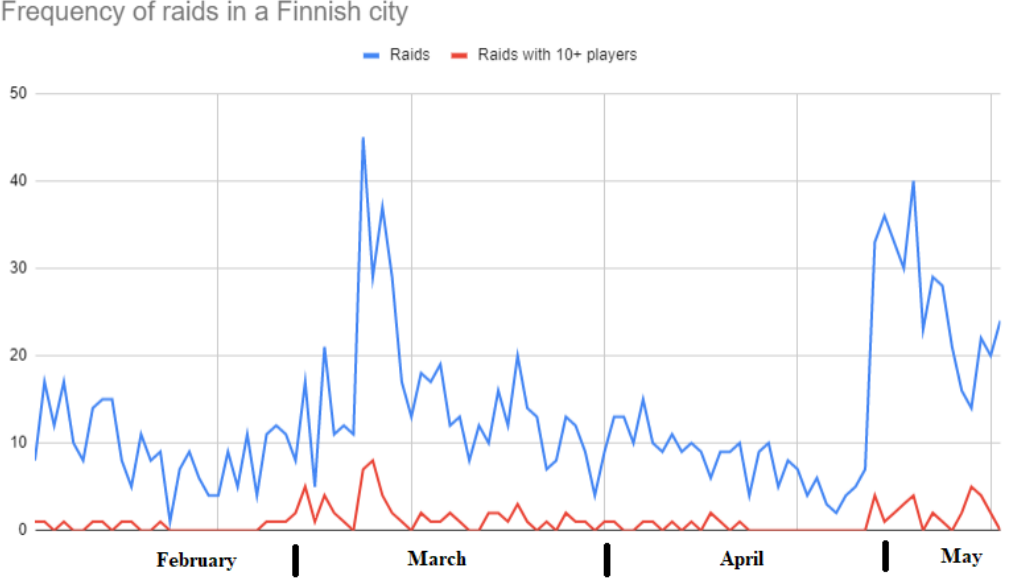
Figure 4. Displaying the changes in daily number of legendary raids organized in the largest public raid chat in a Finnish city during 1 February–12 May 2020. Each column in the figure corresponds to 20